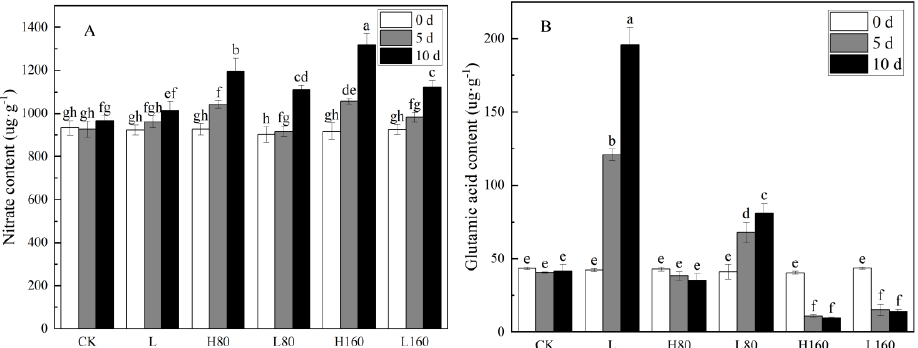
Figure 3. Effects of low R:FR ratio on nitrate content and glutamic acid content in pakchoi under excessive nitrate stress. ( A ): Nitrate content; ( B ): Glutamic acid content.